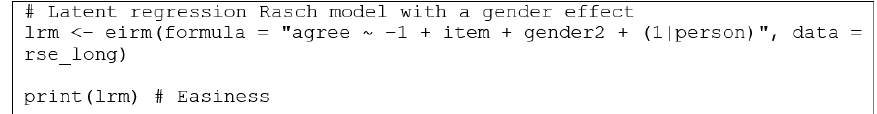
Figure 7. Estimate the latent regression Rasch model and print the model output.